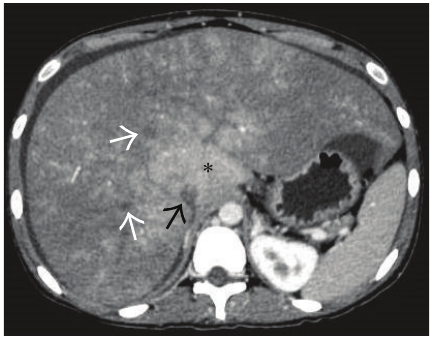
Figure 5: Axial CECT image acquired in the portal venous phase showing enhancement of the caudate lobe (asterisk) while rest of the liver parenchyma in the periphery remains predominantly hypoenhancing. Thrombosed right and middle hepatic veins (white arrows) and IVC (black arrow) can also be